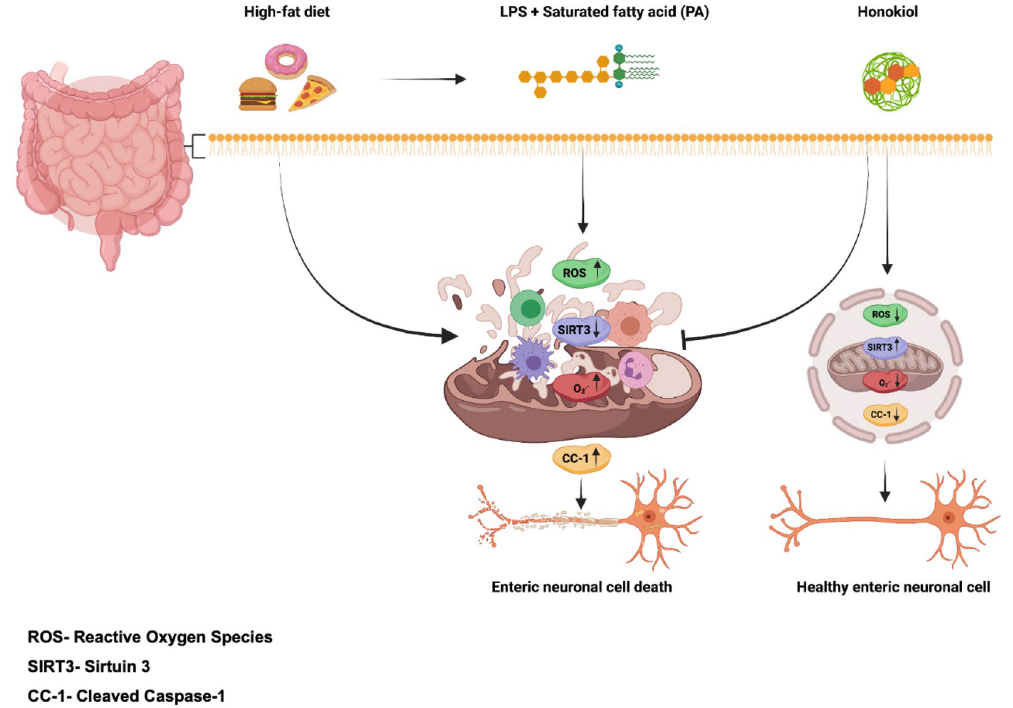
Figure 6. Model illustrating a potential mechanism of Honokiol/Hexafluoro mediated activation of SIRT3 and preventing neurodegeneration in enteric neurons. High-fat diets rich in saturated fatty acids like palmitic acid (PA) and endotoxins like lipopolysaccharide (LPS) can cause metabolic stress in the enteric nervous system via induced ROS, which can lead to SIRT3 depletion mitochondrial sirtuin 3 (SIRT3). SIRT3 depletion causes the generation of pyroptotic markers like cleaved caspase-1. Honokiol and hexafluoro treatment may be increasing SIRT3 expression to reduced mitochondrial ROS and suppress